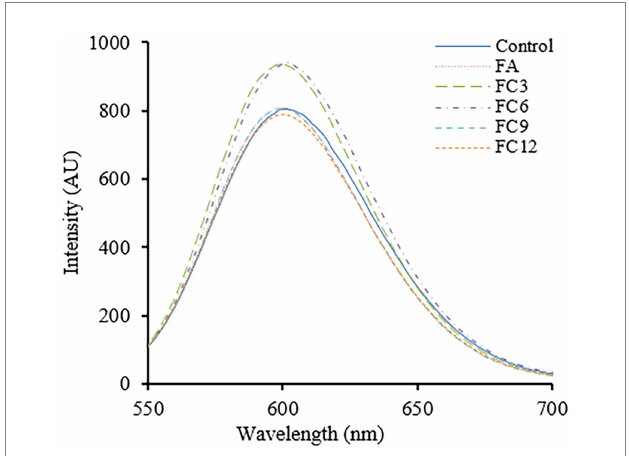
FIGURE 7 Effect on membrane integrity of Pseudomonas